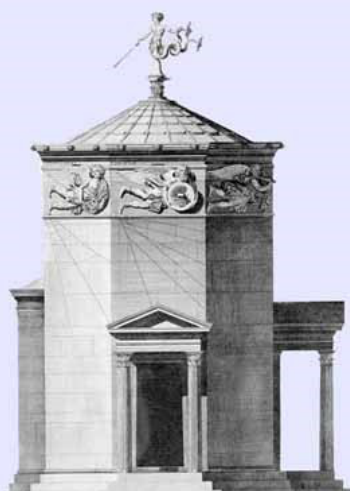
Figure 2: The Tower of the Winds in Athens, as reimagined in 1762 (Wikipedia, 2015)